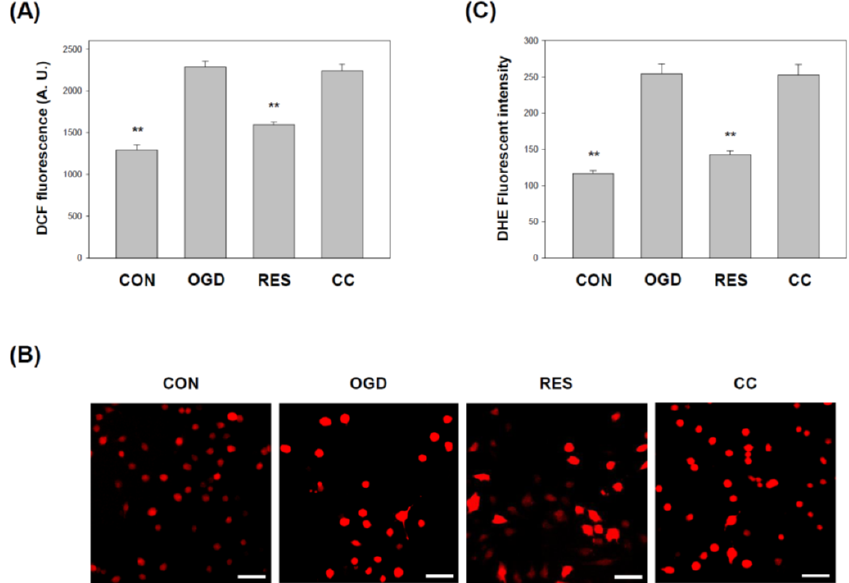
Figure 7. Resveratrol normalized cell-induced oxidative stress by OGD in 3D scaffolds. The cell experiments under the scaffolds were divided into four groups, as described in Figure 1 and the methods section. ( A ) The lysate harvested from the specified conditions was subjected to ROS determination by DCFH-DA. ( B ) Collect cells to show a typical photomicrograph of DHE dye (red). Scale bar: 100 µ m. ( C ) Quantitative data generated by ROS evaluated by DHE fluorescence intensity is normalized to cell number data. Values are expressed as percentages of the indicated level in CON and are presented as the mean ± SEM values from three independent experiments. Specific comparison to the indicated SH-SY5Y cells with OGD ** p < 0.001 vs. cells with